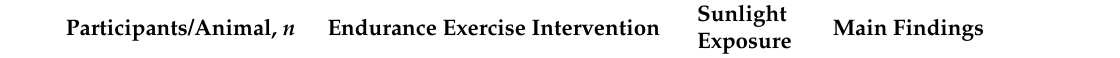
Table 3. Summary of the effect of endurance combined with resistance exercise intervention (human studies and animal